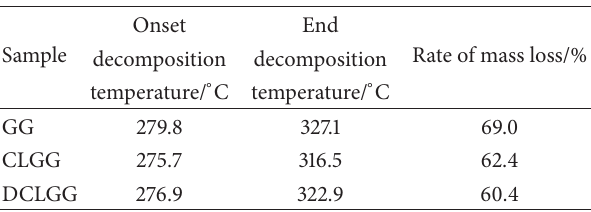
Table 8: Onset decomposition temperature, end decomposition temperature, and mass loss